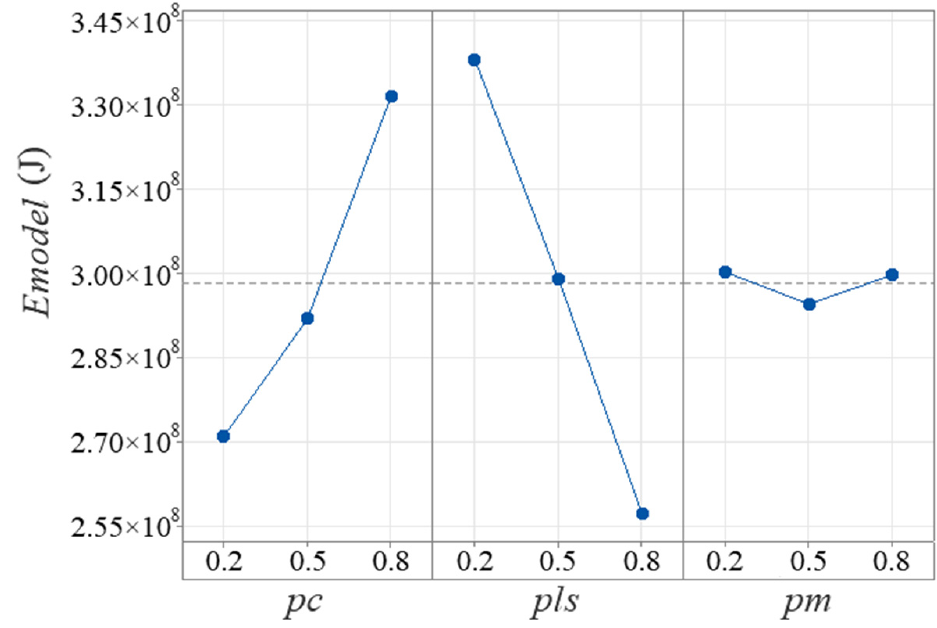
Figure 8. The results of the Taguchi method obtained from Table 3.